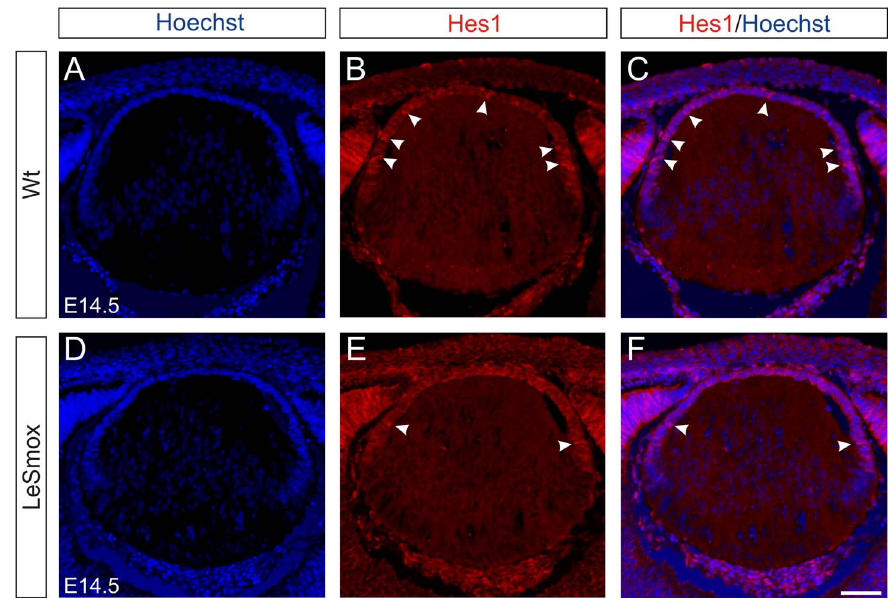
Figure 7. Expression of Hes 1 in LeSmox lenses. Frozen sections stained with Hoechst dye ( A, D ), Hes1 antibody ( B, E ) and respective merged images ( C, F ) from Wt ( A–C ) and LeSmox ( D–F ) lenses at E16.5. A–C . In the wild-type lenses, nuclear reactivity for Hes1 was detected strongly in epithelial nuclei (arrowheds). D–F. Reactivity for Hes1 was mainly cytoplasmic in the LeSmox lenses with only occasional nuclei at the equator showing intense Hes1 reactivity. Scale bar. 100 m